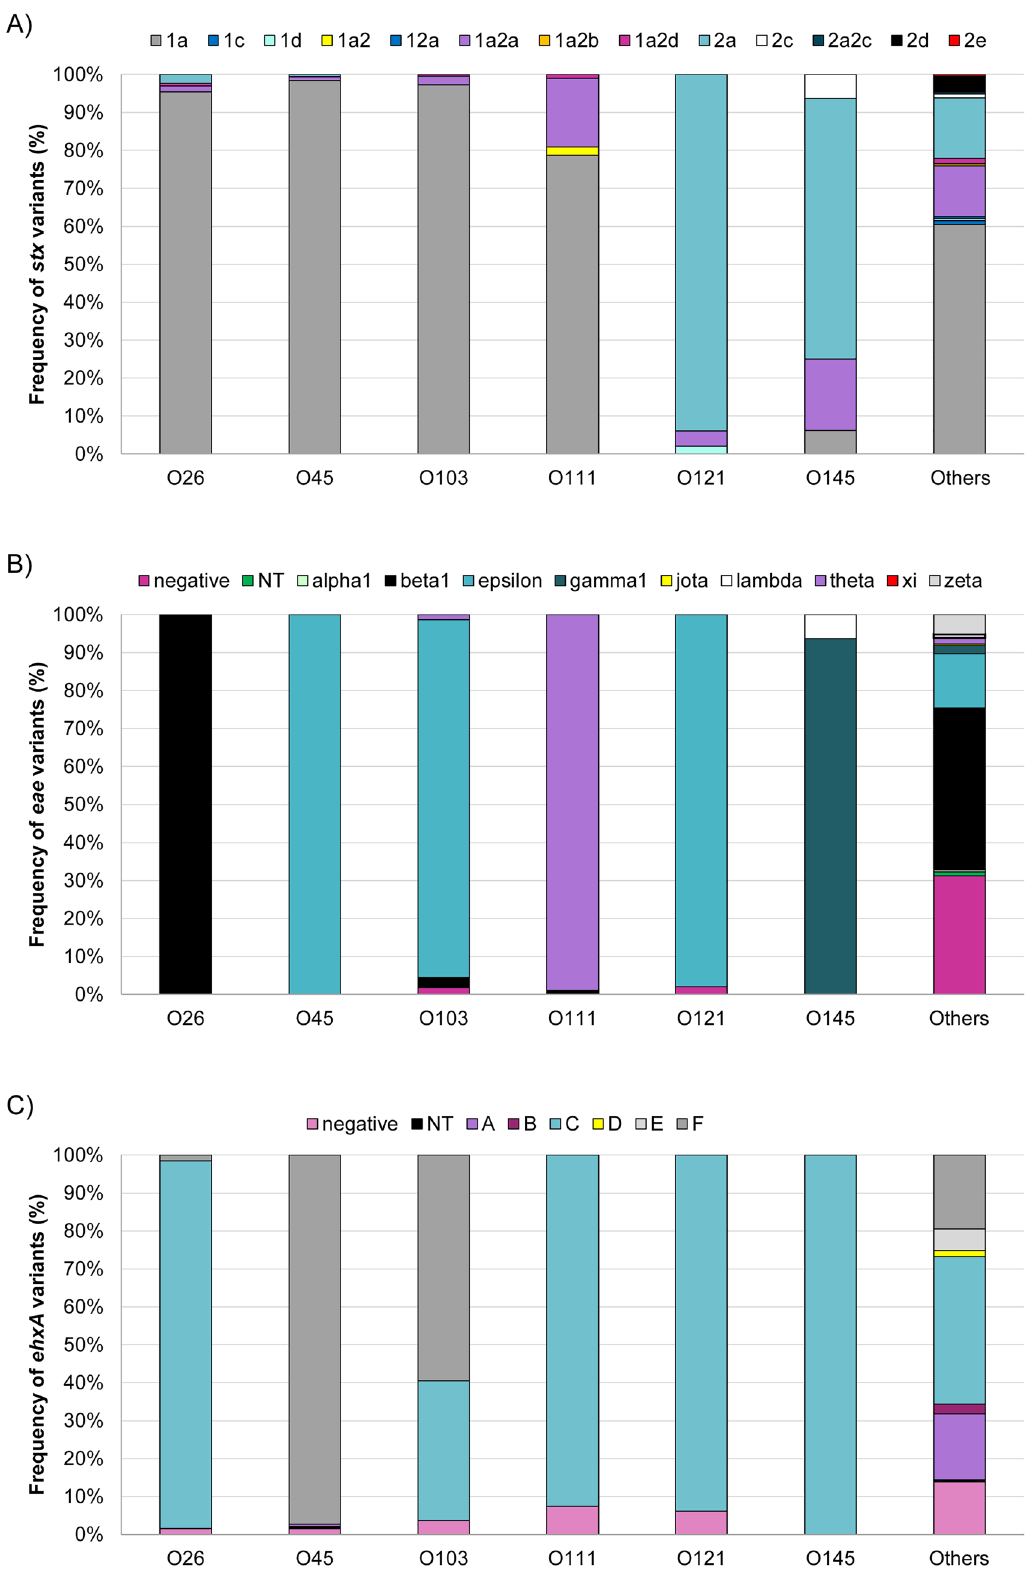
Figure 4. Distribution of gene alleles encoding the ( A ) Shiga toxins ( stx ), ( B) intimin ( eae ), and ( C ) enterohemolysin ( ehxA ) among the predominant non-O157 Shiga toxin-producing Escherichia coli serogroups in Michigan. NT =